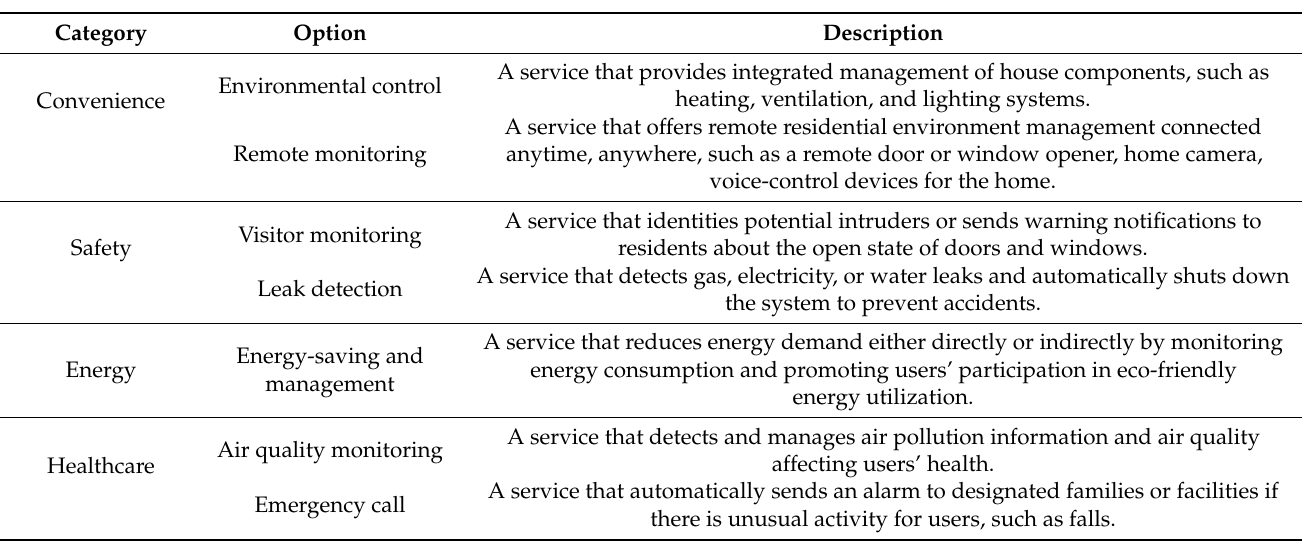
Table 1. Options and descriptions of service preference questionnaire